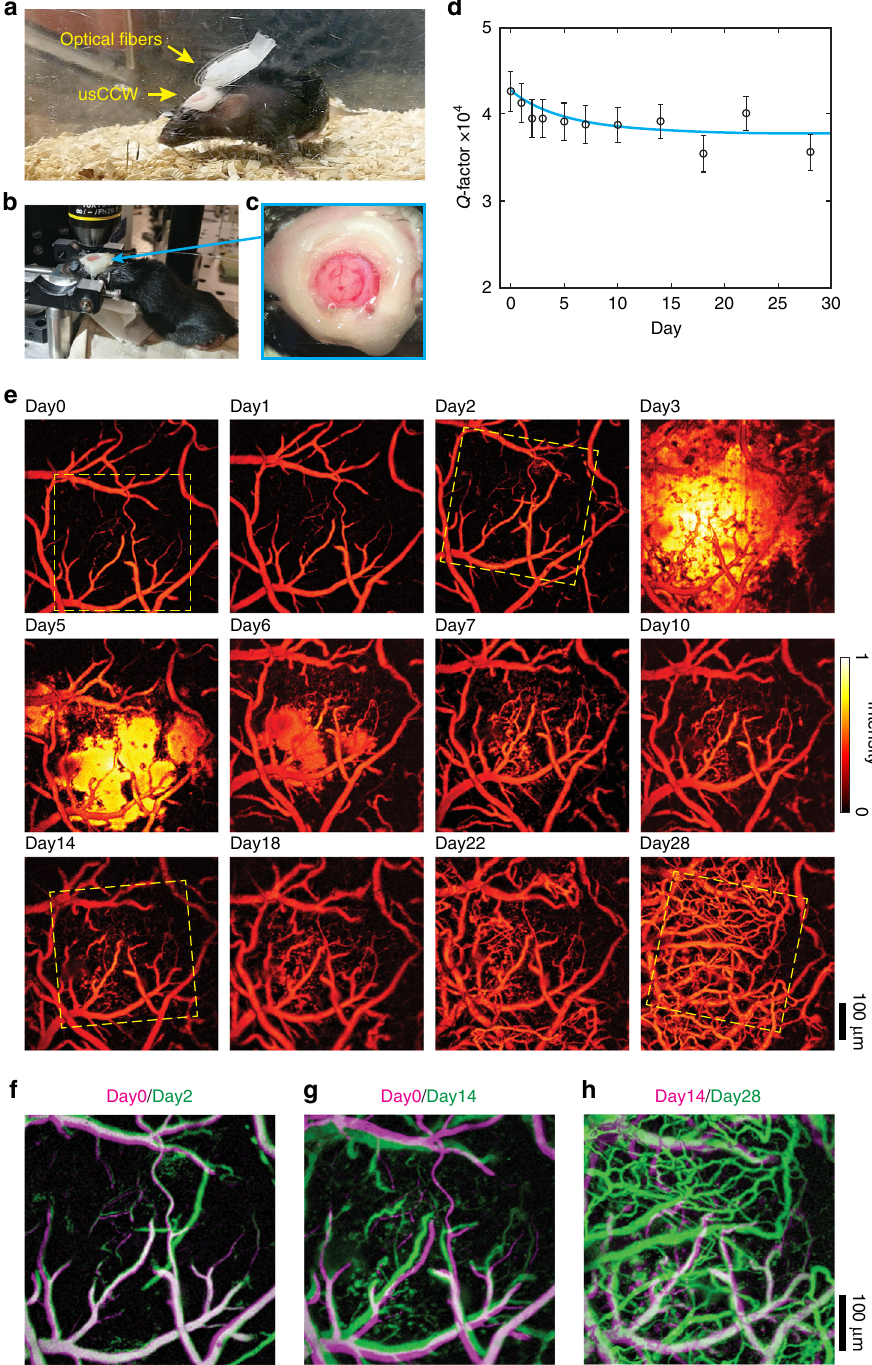
Fig. 5 Longitudinal cortical PAM through the usCCW. a Photograph of a free-moving mouse in the breeding cage after the implantation. b Photograph of the mouse mounted under the microscope during the imaging. c Magin fi ed optical image shows the implanted transparent usCCW and the clear optical view of the cerebral cortax. d Q-factor shows marginal reduction from 4.2 × 10 4 to 3.6 × 10 4 over the 28-day-period. Error bars show the standard deviation of measured results. e Maximum amplitute projections of PAM images show cortical vasculature in the same area over a 28-day-period. Medium post- surgical bleeding occurs at Day 3 and the hemorrhage is gradually cleared in 4 days. Aggressive neovasularization is also clearly observed. The pairwised comparison of the measured cortical vasculature between ( f ) Day 0 and Day 2, ( g ) Day 0 and Day 14, and ( h ) Day 14 and Day 28. Superposition of two images rendered in distinct megenta and green colors is used to provide direct visualization of the neovascularization process. The overlapping regions are therefore rendered in white